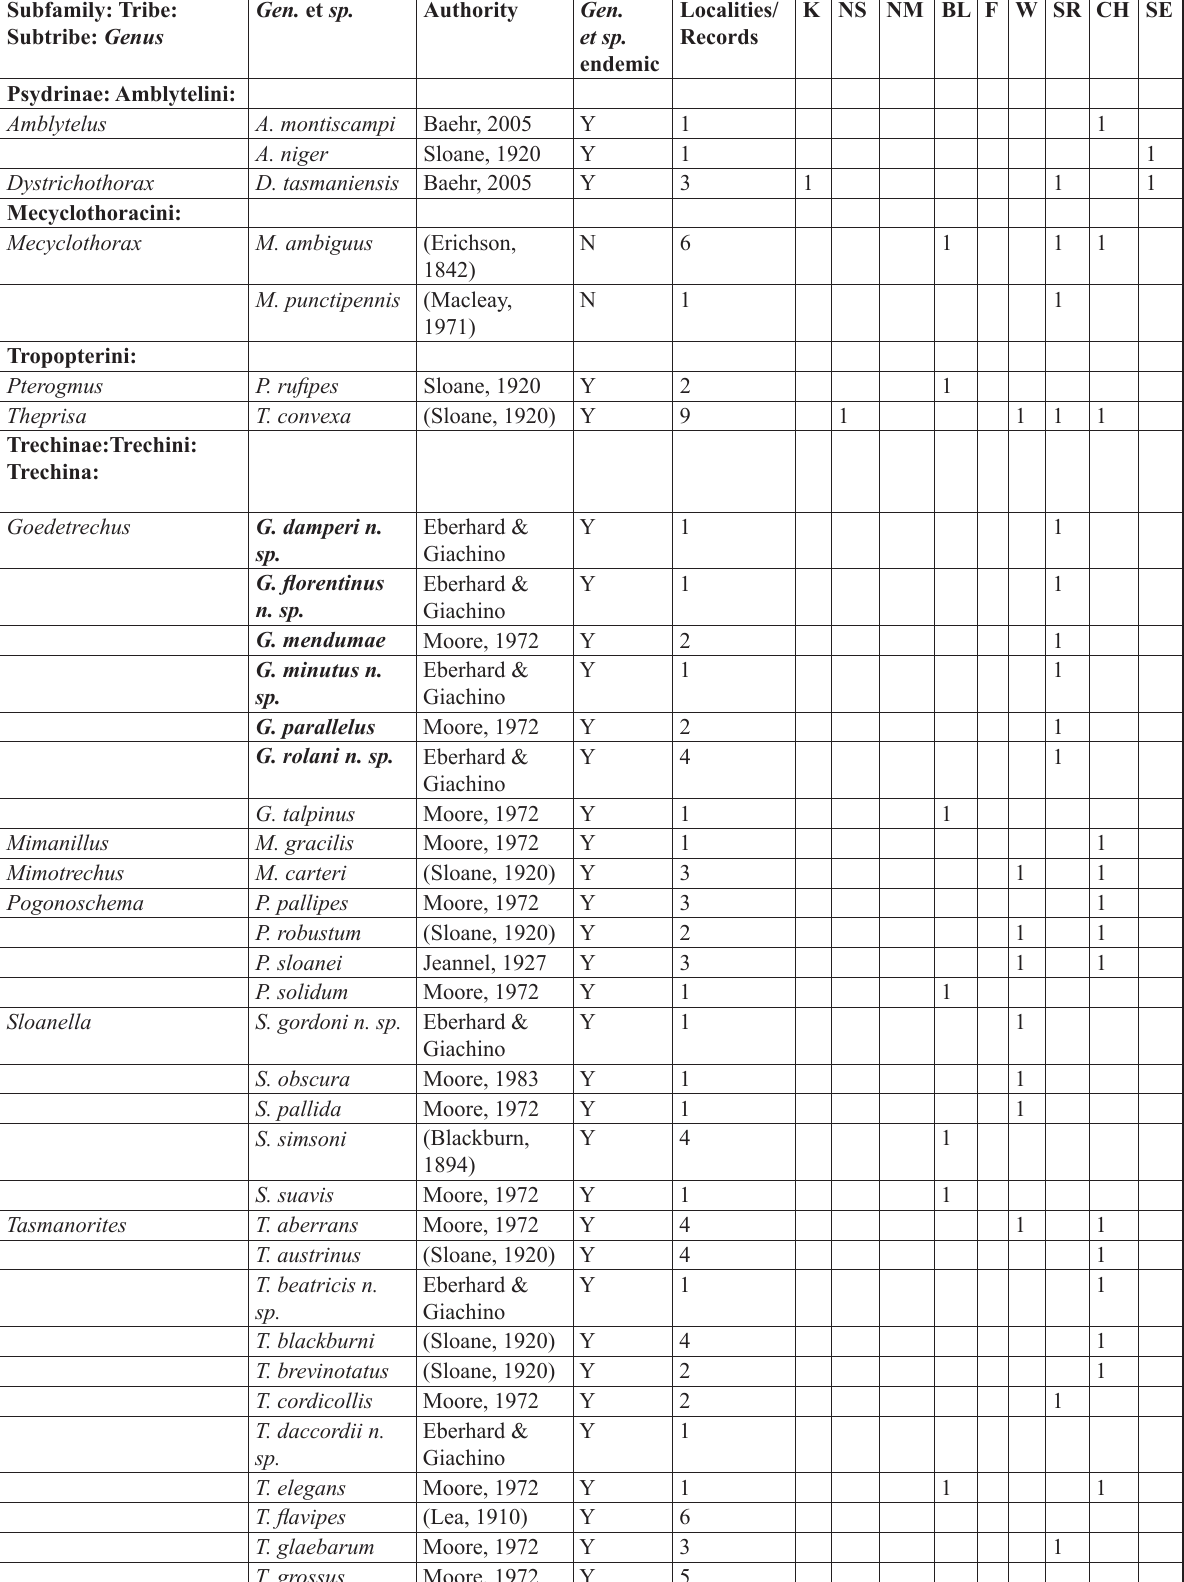
Table 2 - Systematic checklist of described Tasmanian Trechinae (excluding Bembidiini) and treated Psydrinae, including the number of collection localities / records (this manuscript and published literature) and IBRA regions where present. Troglobitic species are highlighted in bold. IBRA abbreviations: King (K), Northern Slopes (NS), Northern Midlands (NM), Ben Lomond (BL), Fliners (F), West (W), Southern Ranges (SR), Central Highlands (CH), South East